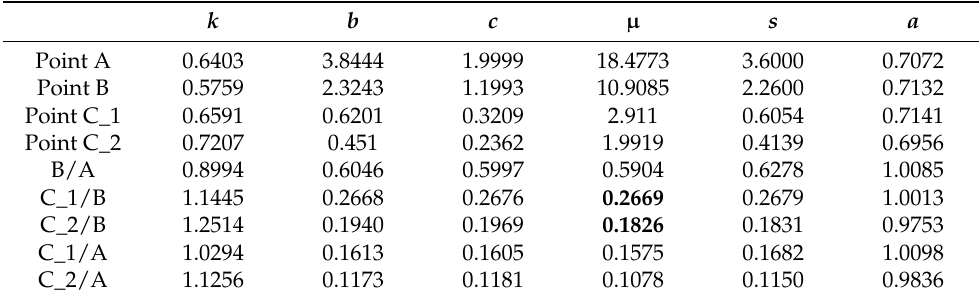
Table 4. The values characterizing the density distributions for points A, B, and